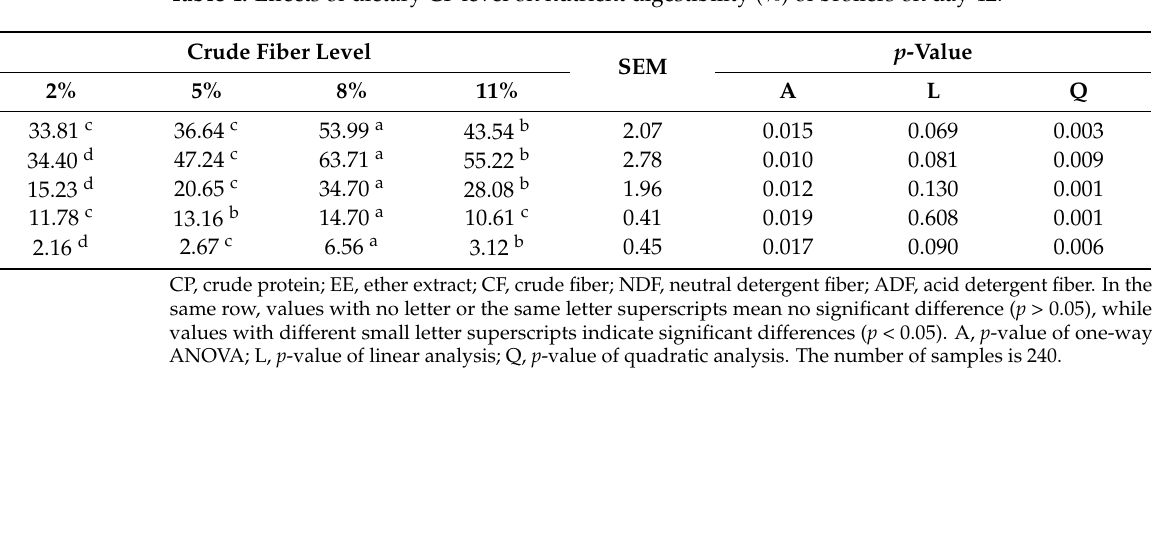
Table 4. Effects of dietary CF level on nutrient digestibility (%) of broilers on day